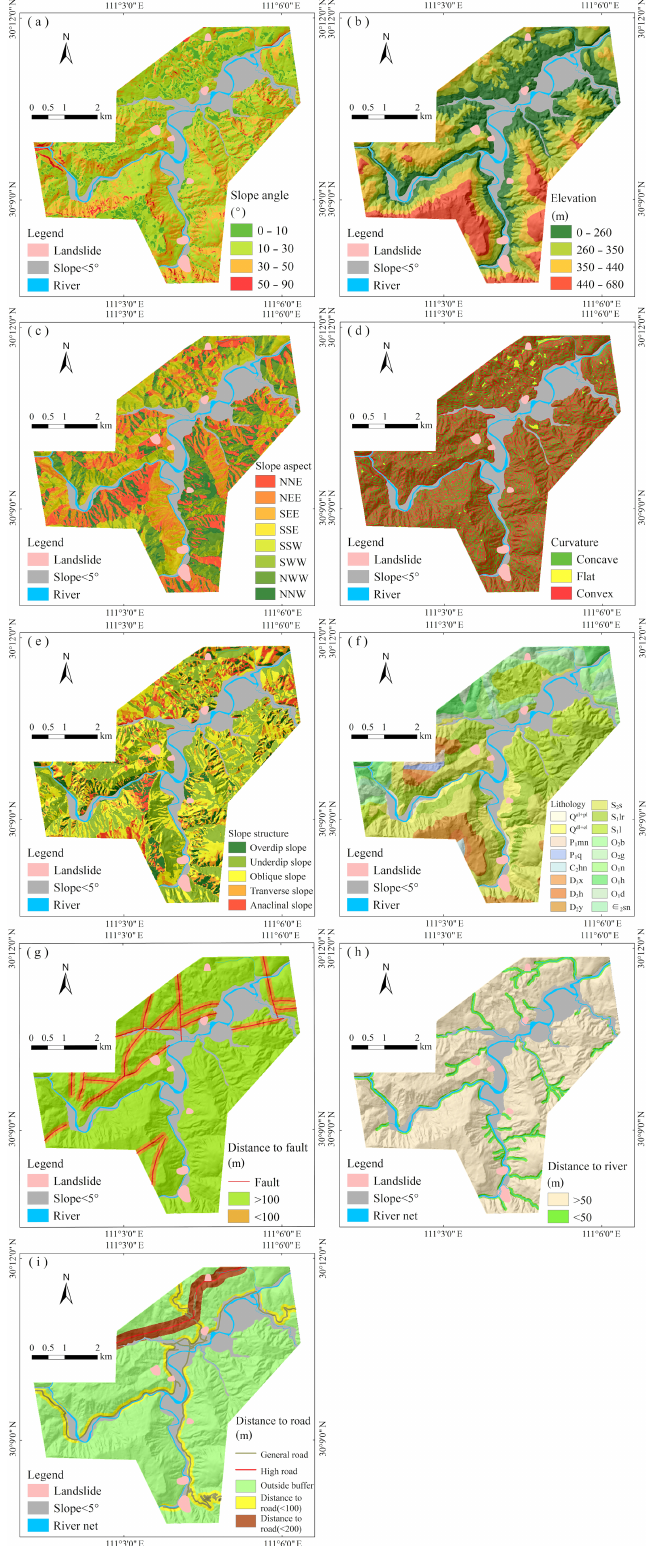
Figure 4. Thematic maps for landslide susceptibility mapping: (a) slope, (b) elevation, (c) slope aspect, (d) curvature, (e) slope structure, (f) lithology, (g) distance to fault, (h) distance to river, and (i) distance to